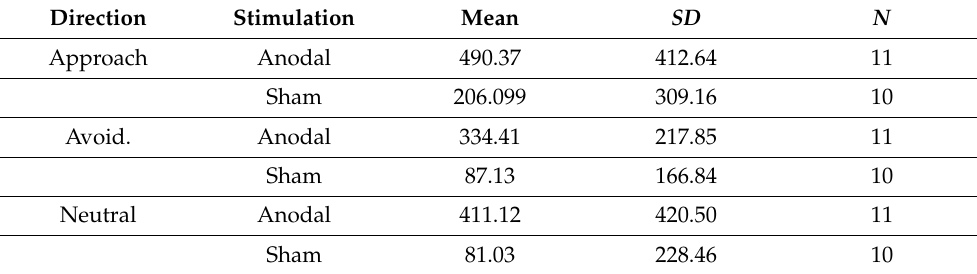
Table 4. Descriptive statistics of d for low-BAS participants in each condition.